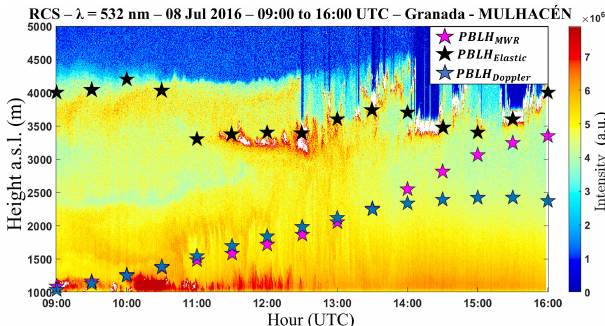
Figure 15. Time–height plot of RCS obtained from MULHACÉN elastic lidar data on 8 July 2016 in Granada. Pink stars represent the PBLH MWR , black stars represent the PBLH Elastic and blues stars represent the PBLH Doppler